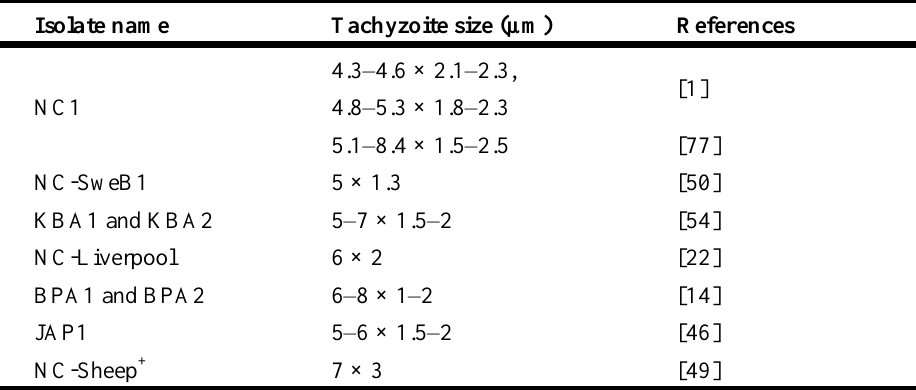
Table 2. Size of tachyzoites from different Neospora caninum